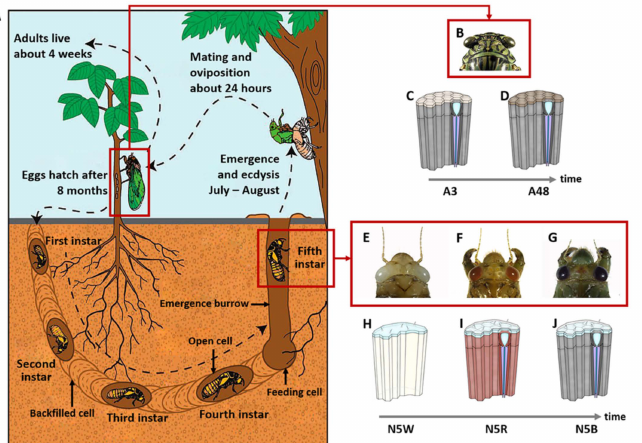
Figure 1. Lifecycle and development of compound eyes of M. mongolica during 5th-instar nymphal stage and adult stage ( A ) Lifecycle of M. mongolica , adapted with permission from Ref. [19]. ( B ) Head including compound eyes of an adult. ( C ) Ultrastructure of compound eyes of the adult after emergence at 3 h (A3). ( D ) Ultrastructure of compound eyes of the adult after emergence at 48 h (A48). ( E ) Head including white compound eyes of a nymph. ( F ) Head including compound eyes of a nymph with red eyes. ( G ) Head including dark-brown compound eyes of a nymph. ( H ) Structure of a white compound eye in 5th-instar nymphal stage (N5W). ( I ) Structure of a red compound eye in 5th-instar nymphal stage (N5R). ( J ) Structure of a dark-brown compound eye in 5th-instar nymphal stage